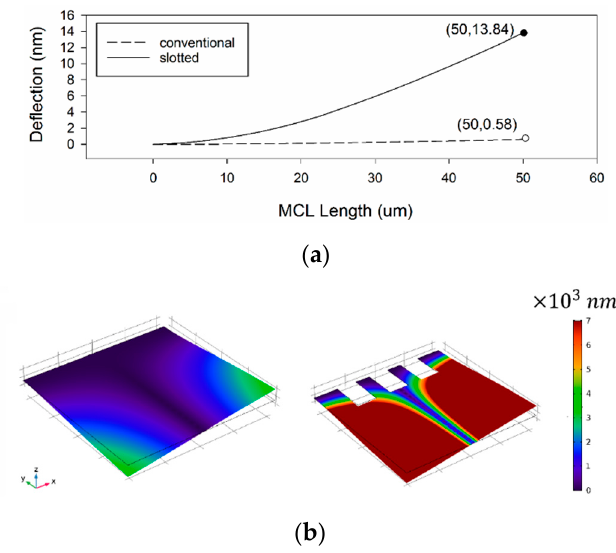
Figure 11. Deflection variation of MCLs along its length. ( a ) Comparison of slotted and conventional MCLs deflection, ( b ) 3D visualization of slotted and conventional MCLs deflection in torsional mode ( σ lw = 1).